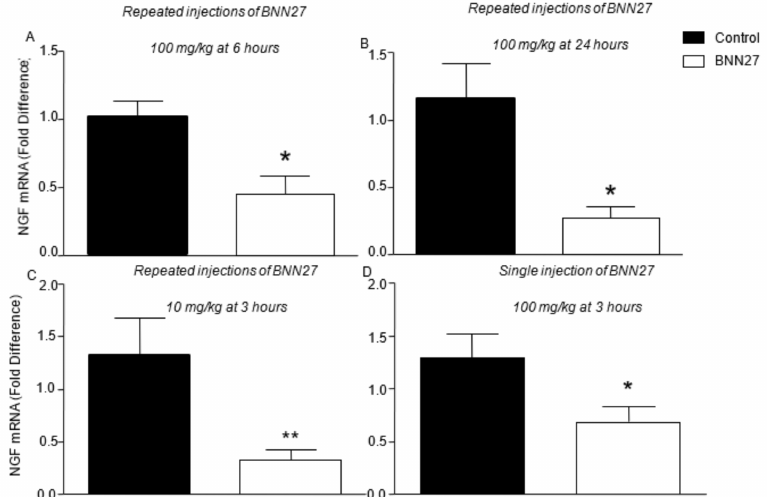
Figure 9. BNN27 inhibited the expression of NGF in DRG at all time points and doses tested. ( A ) Repeated injections of BNN27 at 100 mg/kg at 6 h: Control n = 3 mice, BNN27-treated group n = 3 mice. ( B ) Repeated injections of BNN27 100 mg/kg at 24 h: Control n = 6 mice, BNN27-treated group n = 5 mice. ( C ) Chronic treatment with BNN27 10 mg/kg: Control n = 8 mice, BNN27-treated group n = 10 mice. ( D ) Single treatment with BNN27 100 mg/kg: Control n = 7 mice, BNN27-treated group n = 9 mice In all panels * p < 0.05, ** p < 0.01. Statistical analysis was performed using unpaired t -tests. All data are expressed as the mean ±